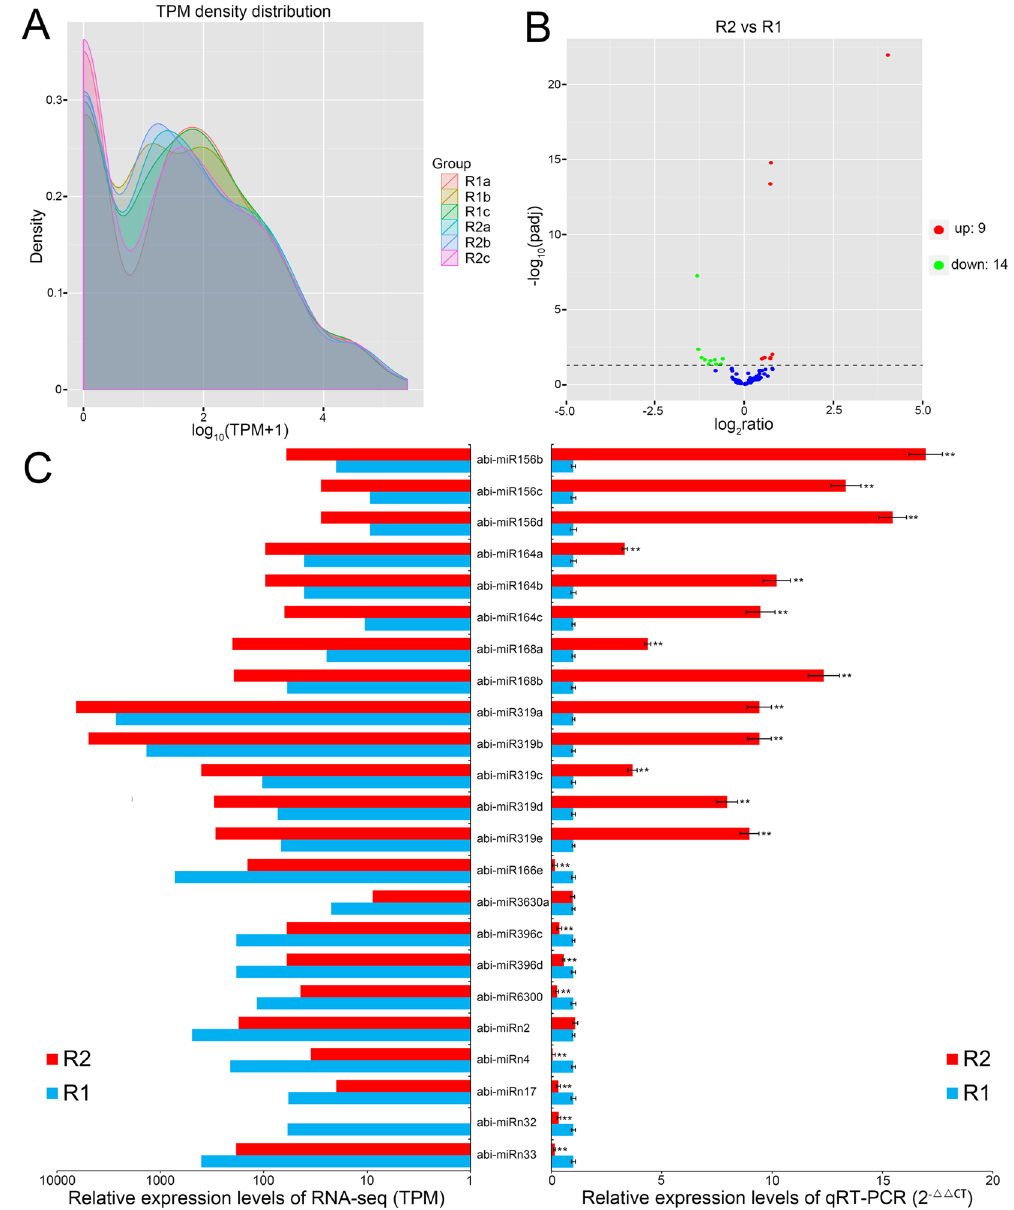
Figure 4. TPM density distribution ( A ), scatterplot ( B ), and RNA-seq and qRT-PCR analysis comparison ( C ) of DE miRNAs between R1 and R2